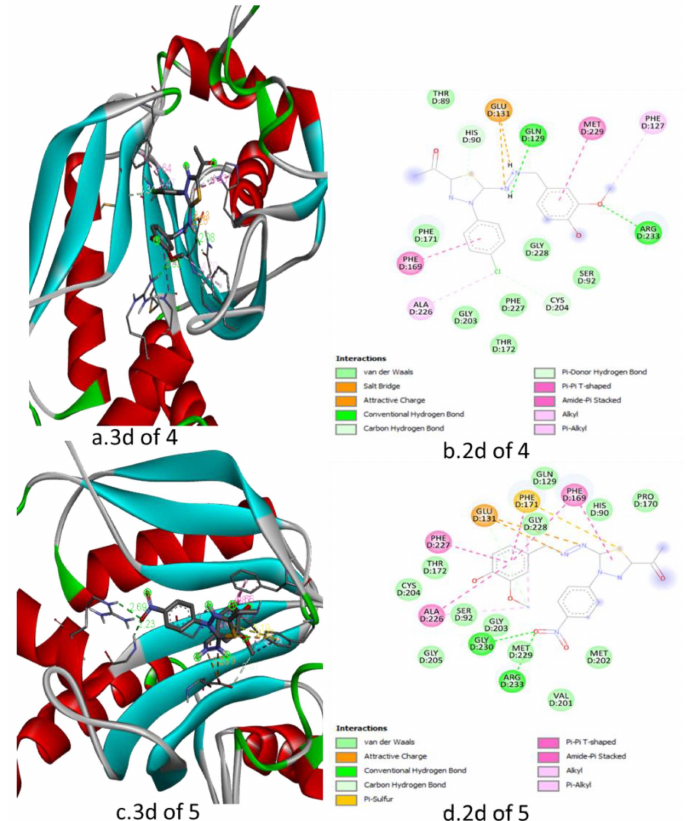
Figure 4. Interaction of the docked compounds 4 and 5 with PheRS.